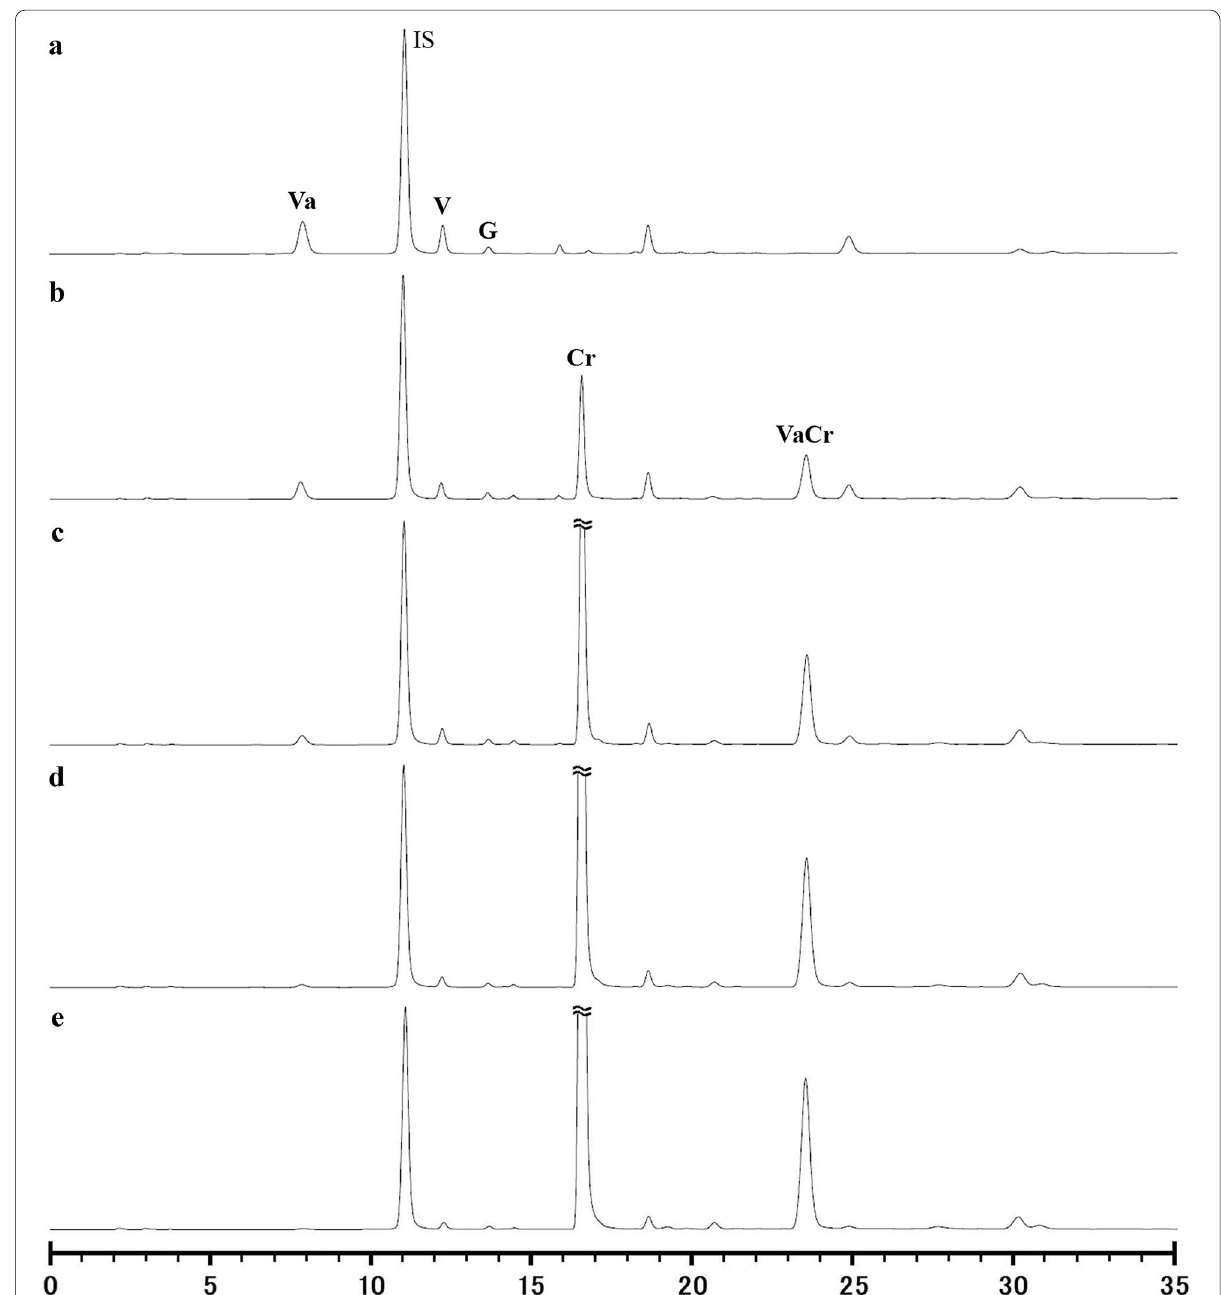
Fig. 5 HPLC chromatograms of the reaction solutions obtained after 120 min in the systems ( a Cr0, b Cr10, c Cr25, d Cr50, and e